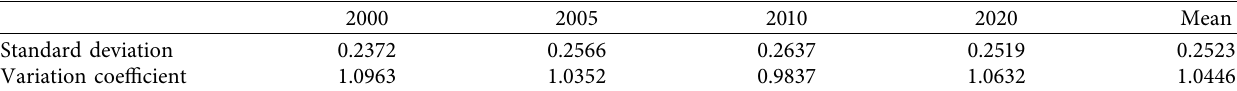
Table 3: Variation coefficients of regional spatiotemporal development of higher